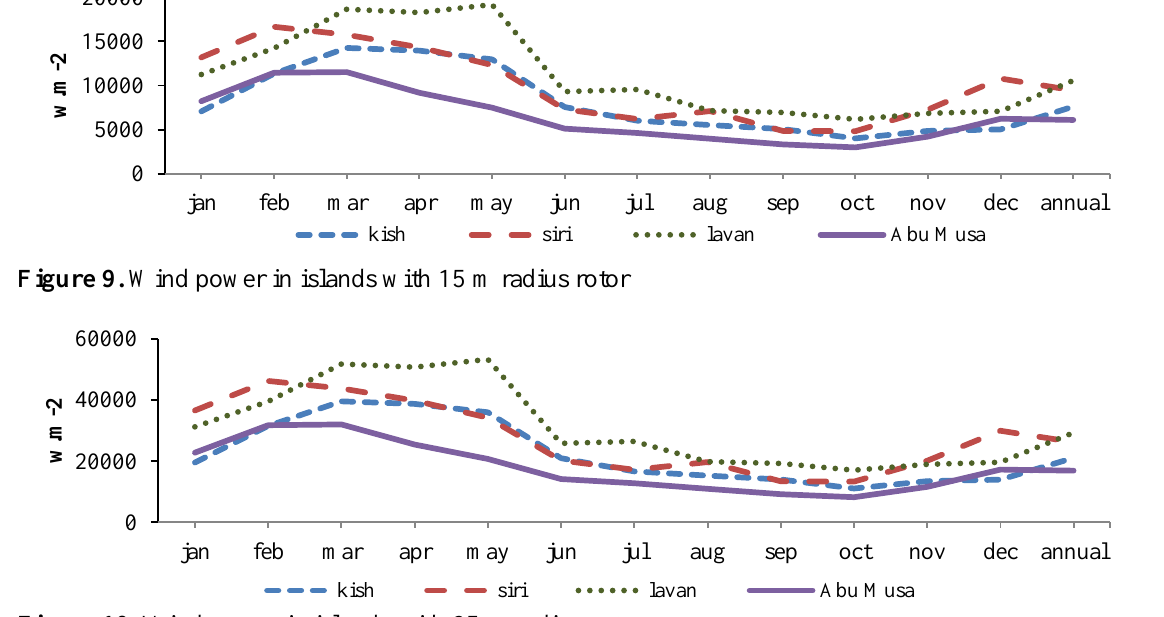
Figure 10. Wind power in islands with 25 m radius